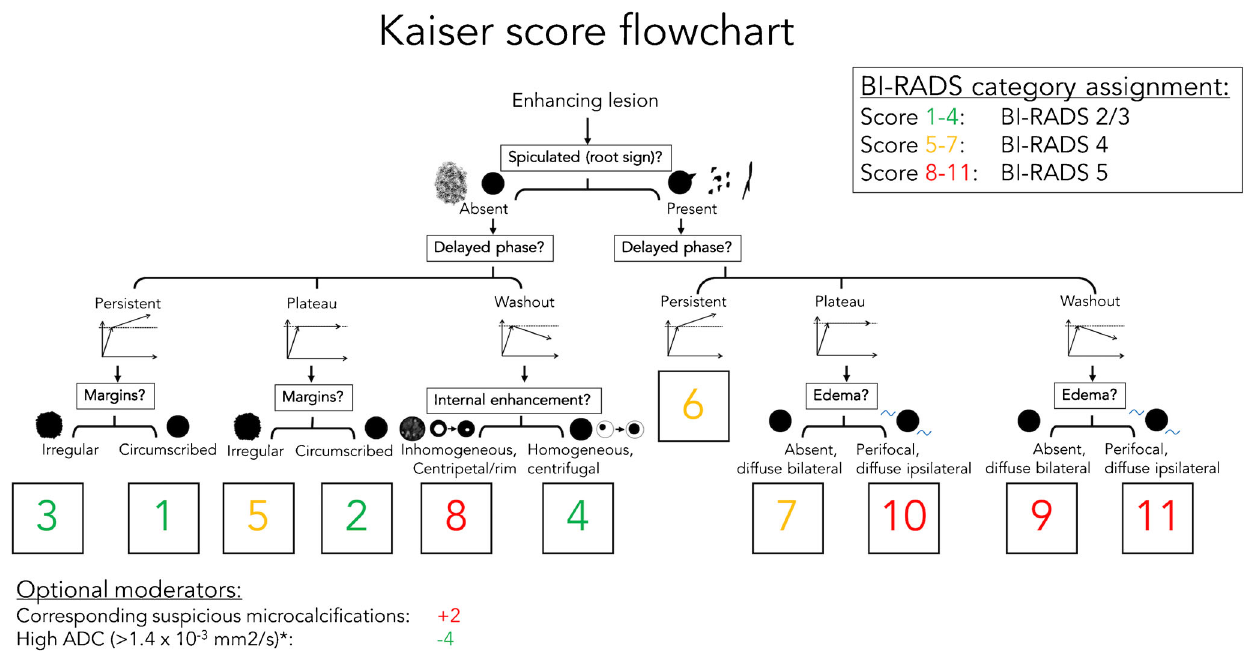
Fig. 7 The Kaiser score flowchart. The Kaiser score is assigned by following a simple flowchart from the top to the bottom, which lets the reader assign the presence or absence of four diagnostic criteria (presence ofspiculation being a formal subgroup of margin assessment according to BI-RADS). The resulting score is associated with an increasing risk of malignancy (from 1 to 11) and can be translated into BI-RADS categories